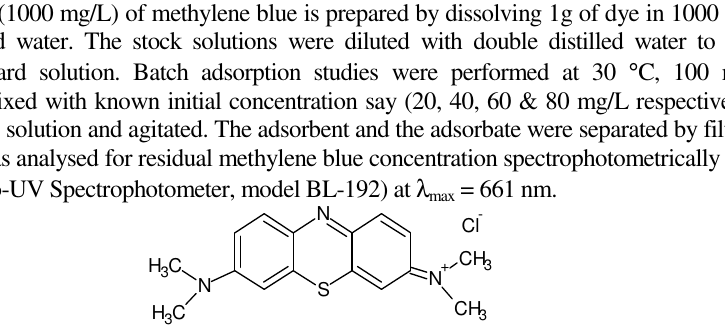
Figure 1. Structure of methylene